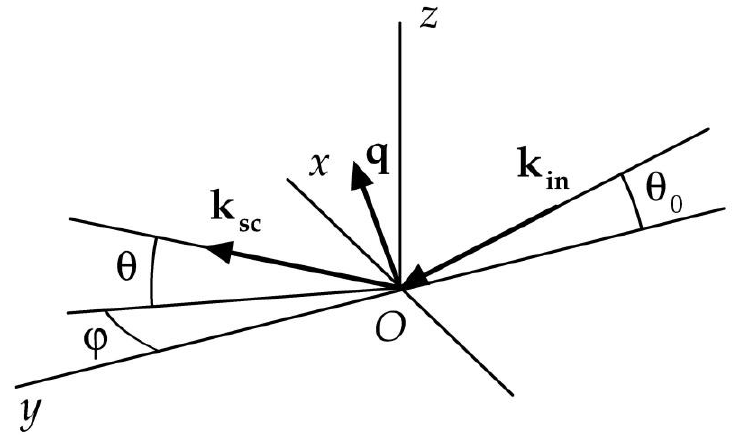
Figure 1. Schema of the X-ray scattering process and associated coordinate system. The origin point O is at the center of the illuminated region, the x,y plane coincides with the sample surface, the z axis is directed along the normal to the surface plane, and the x axis is perpendicular to the incident beam direction. The incident beam vector is k in ; the grazing angle is θ 0 ; the scattered beam vector is k sc ; the scattering vector equals q = k in – k sc .